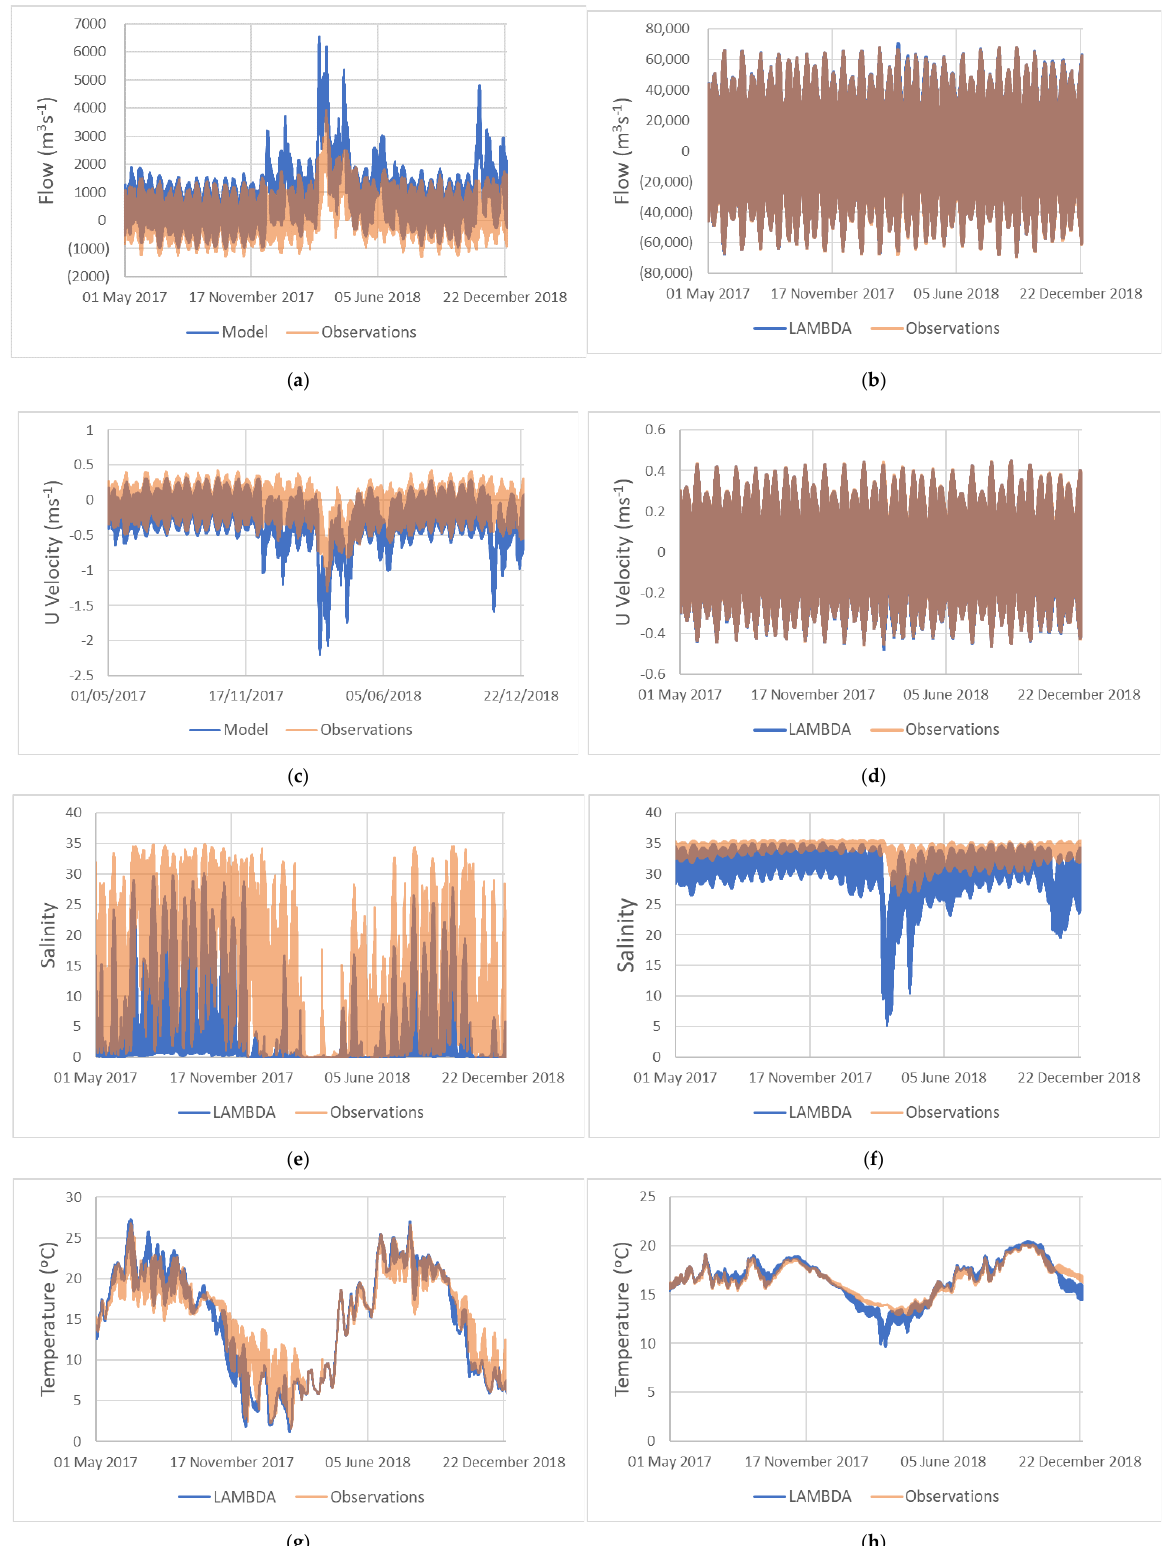
Figure 6. Flow ( a , b ), zonal velocity ( c , d ), salinity ( e , f ) and temperature ( g , h ) obtained at the mouth of the estuary proxy forced with observed (Orange line) and modelled (Blue line) river flows in the Douro (left) and Tagus (right) estuaries for the period of May 2017–December 2018. Brown colours indicate overlapping values. Table 2. Basic statistics for the outputs from the Tagus and Douro proxies when forced with ob- served flows (Obs.) and when forced with watershed models (Model). * Values were calculated with the absolute values.